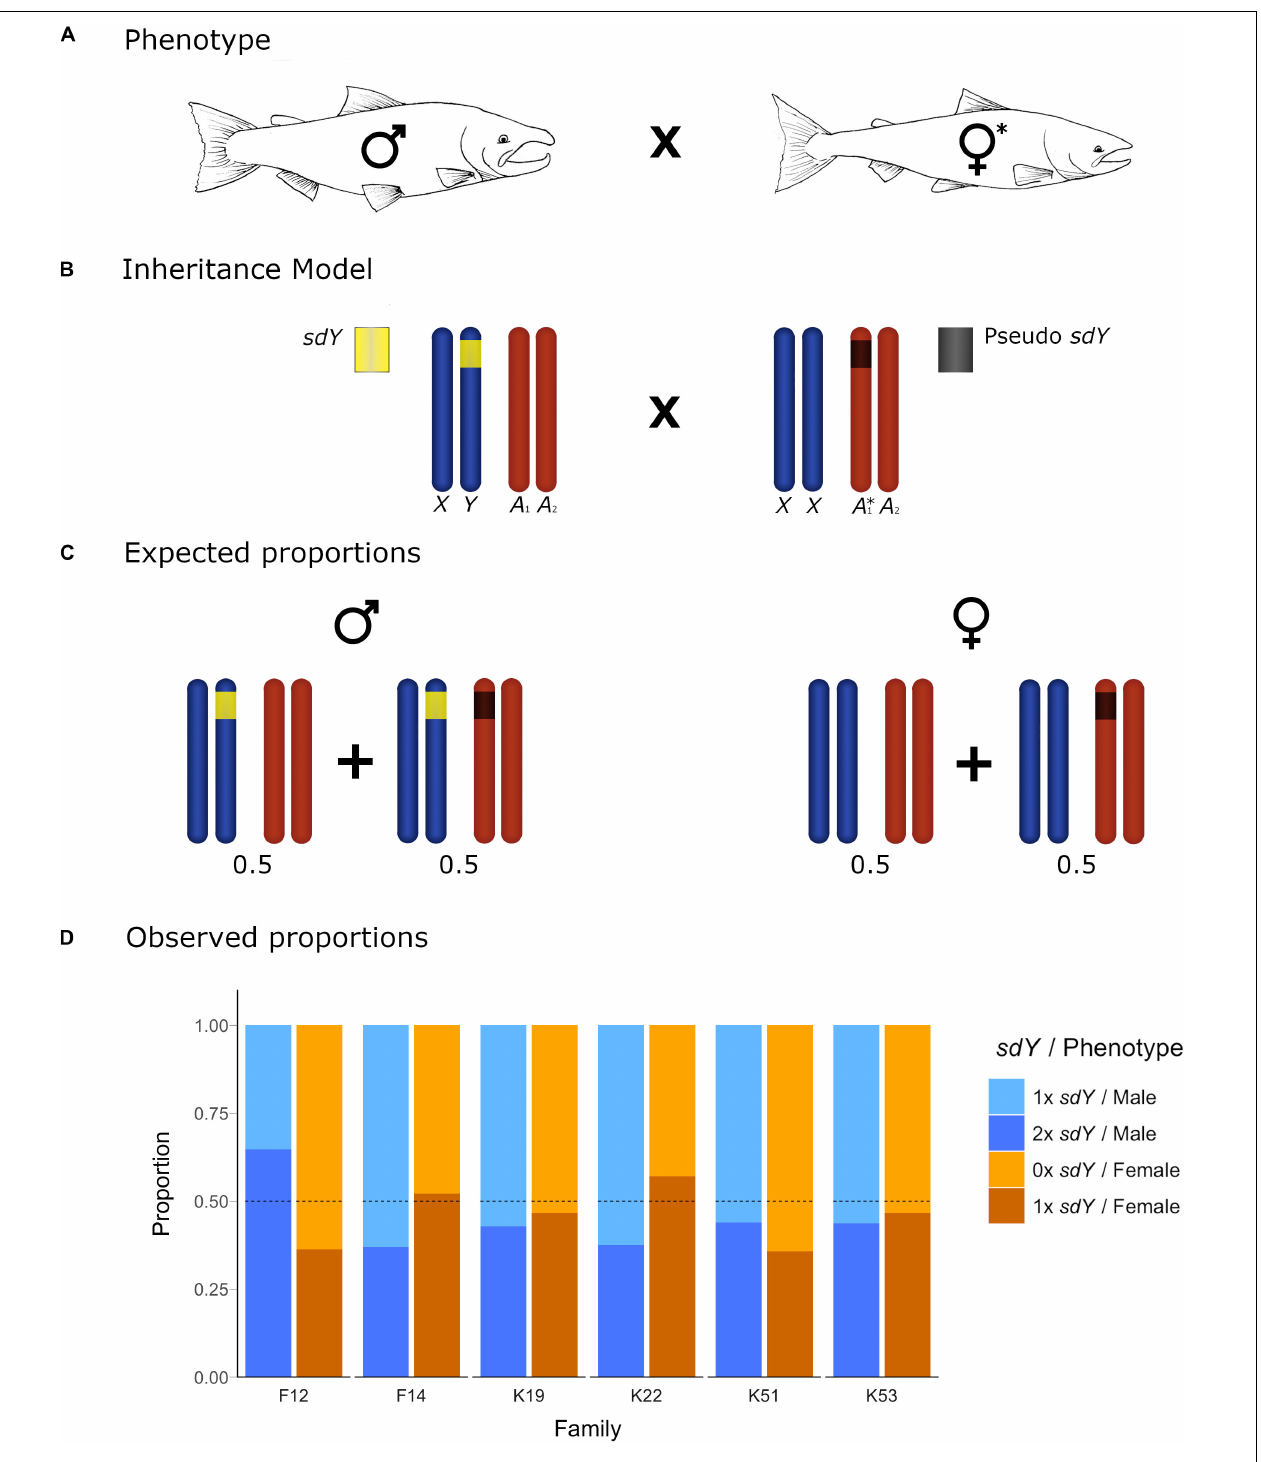
FIGURE 3 | Conceptual diagram showing the inheritance model and the observed frequencies for the offspring of crosses with one parental individual carrying an sdY pseudocopy. (A) Cross between a 1 × sdY phenotypic male and a 1 × sdY discordant female denoted with ∗ . (B) conceptual diagram showing the inheritance model at a chromosome level. Sex chromosomes and autosomes are represented in dark blue and dark orange, respectively. Normal 1 × sdY male (left) carrying a copy of the sex determining sdY gene (yellow) in the Y chromosome. Discrepant 1 × sdY phenotypic female (right) carrying an sdY autosomic pseudocopy (dark gray) in heterozygosis. (C) Males and females expected proportions for the different sdY genotypes (1–2 × ). (D) Offspring observed proportions for the affected families of 1 × and 2 × sdY males and 0 × and 1 × sdY females: light blue, blue, light orange and orange, respectively. Dotted lines represent the sdY genotype expected